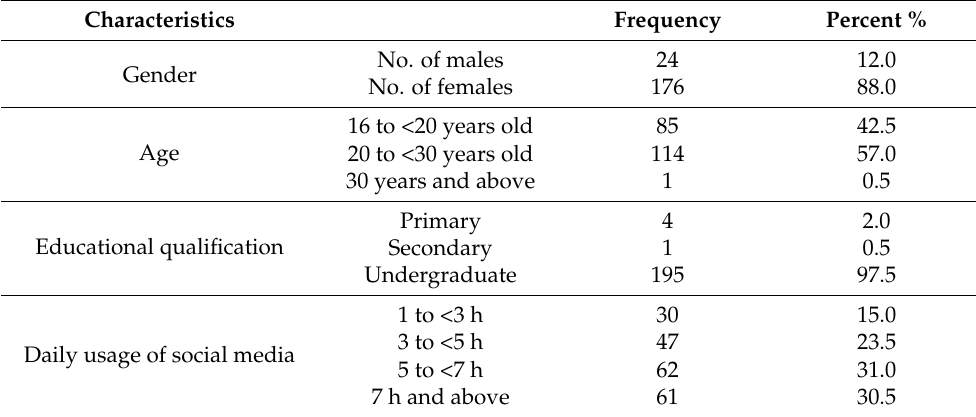
Table 2. Respondents’ descriptive statistical, demographic